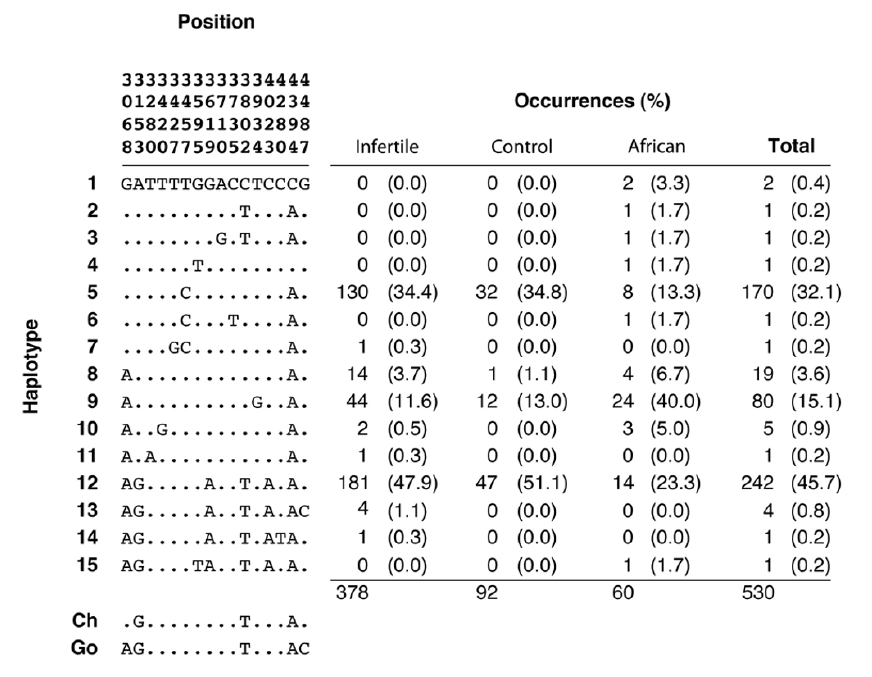
gorilla.Summary of inferred haplotype data Figure 3 Summary of inferred haplotype data. In the left panel, each column represents a variable nucleotide position and the row indi- cates the nucleotide found at that position in the given haplotype. Dots indicate identity with the reference haplotype (arbitrar- ily chosen from among the haplotypes inferred in our sample). In the right panel, numbers indicate the number of occurrences of each haplotype in each subsample. Ch = chimpanzee, Go =